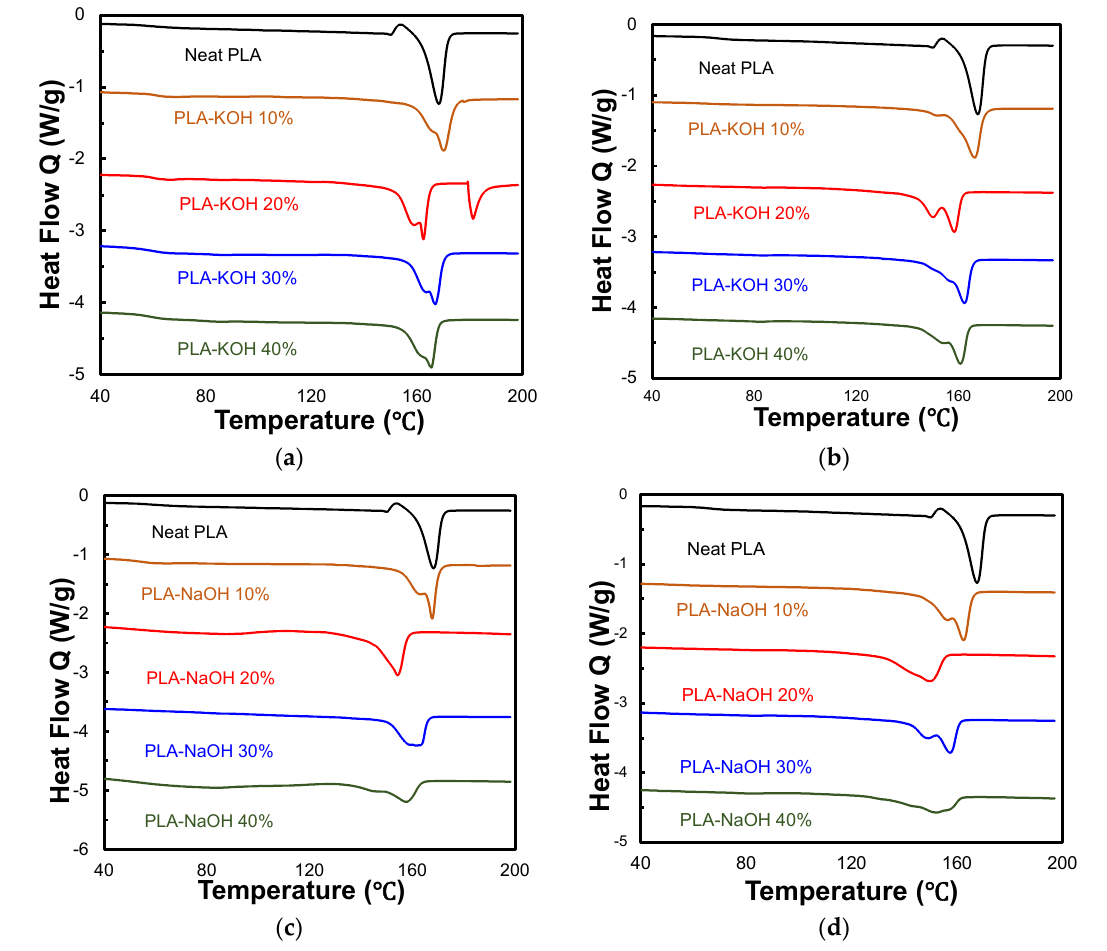
Figure 5. ( a ) PLA-KOH 1st heating cycle; ( b ) 2nd heating cycle; ( c ) PLA-NaOH 1st heating cycle; ( d ) 2nd heating cycle.